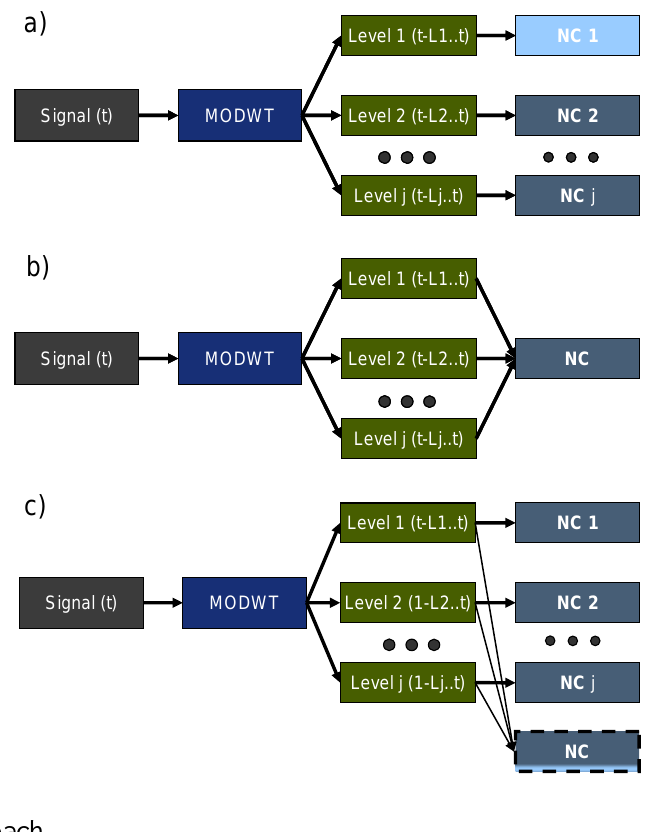
Figure 5. Three options for Maximum Overlap Discrete Wavelet Transform (MODWT) combination with Neural Clouds (NC). ( a ) Each level of MODWT decomposition is analysed by the individual instance of NC. ( b ) All levels of MODWT decomposition are analysed by one instance of NC. ( c ) A combination of (a) and